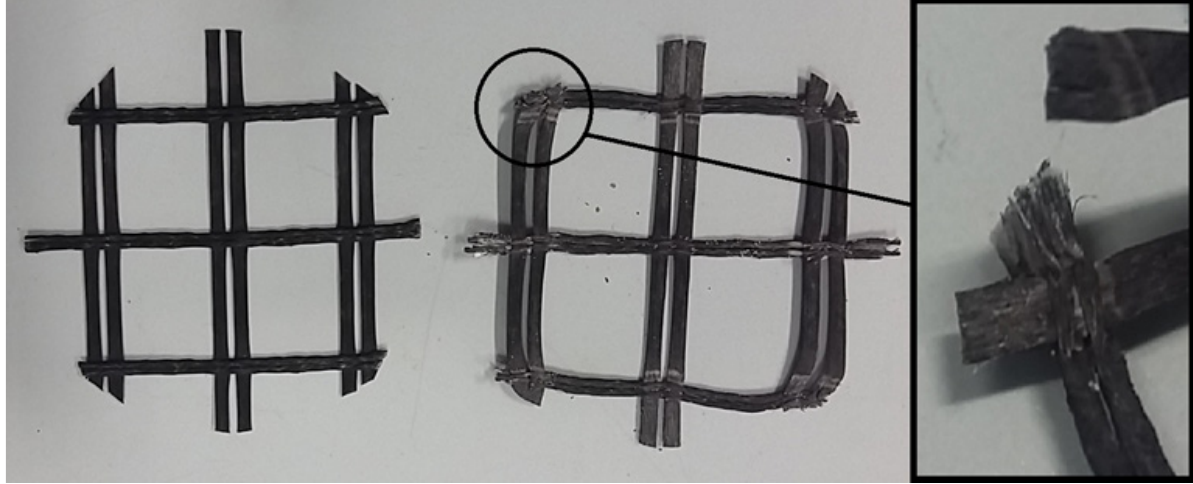
Figure 7: Basetrac ® Grid PET 40 geogrid condition: left – geogrid without damages before test; right – geogrid damages after